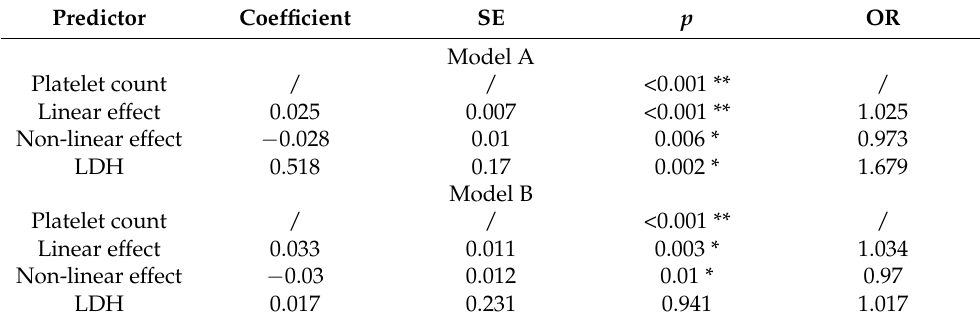
Table 2. Parameter estimates, odds ratio (OR) and associated inferential statistics for all